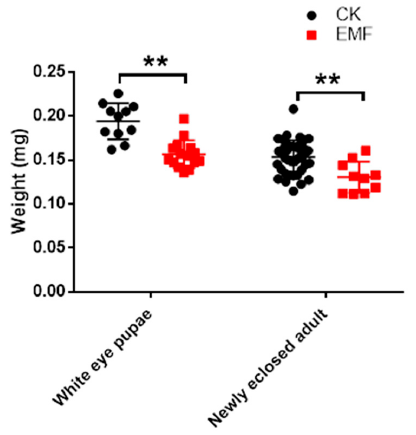
Figure 2. Effect of ELF-EMF exposure on the weight of while-eye pupae and newly emerged adults of A. cerana . EMF: ELF-EMF exposed group (Red square). CK: Control group (Black dot); ELF-EMF exposure significantly decreased the weight of white-eye pupae and newly emerged adult ( t -test: for the white eye pupae, t = 6.623, df = 22, p < 0.0001; for the newly emerged adult, t = 3.427, df = 47, p = 0.0013). Note: ** means p < 0.01.